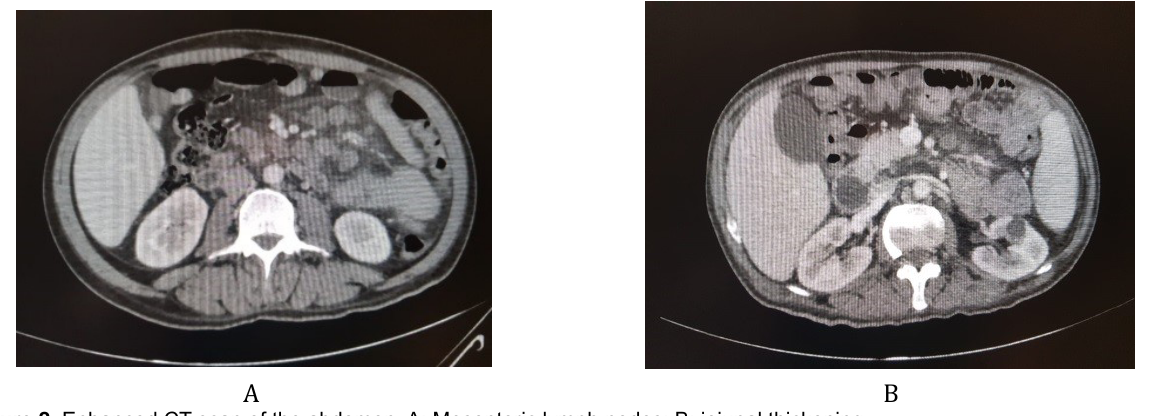
Figure 2. Enhanced CT scan of the abdomen. A: Mesenteric lymph nodes; B: jejunal thickening